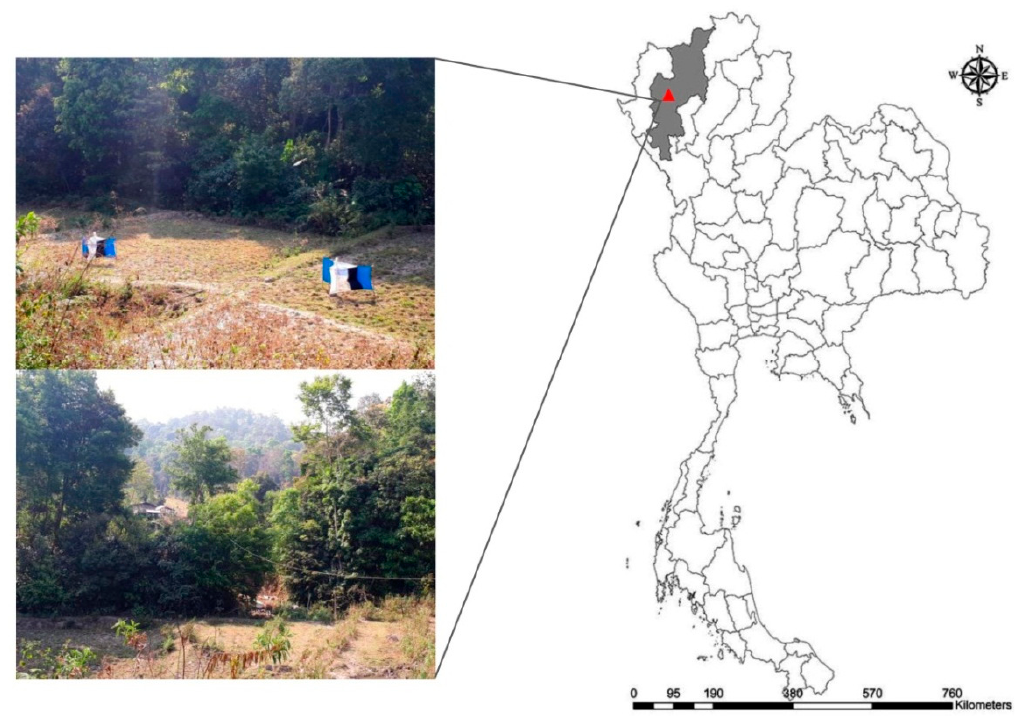
Figure 1. Map showing the collection site of Haematobosca aberrans Pont, Duvallet & Changbunjong, 2020 in Thailand.